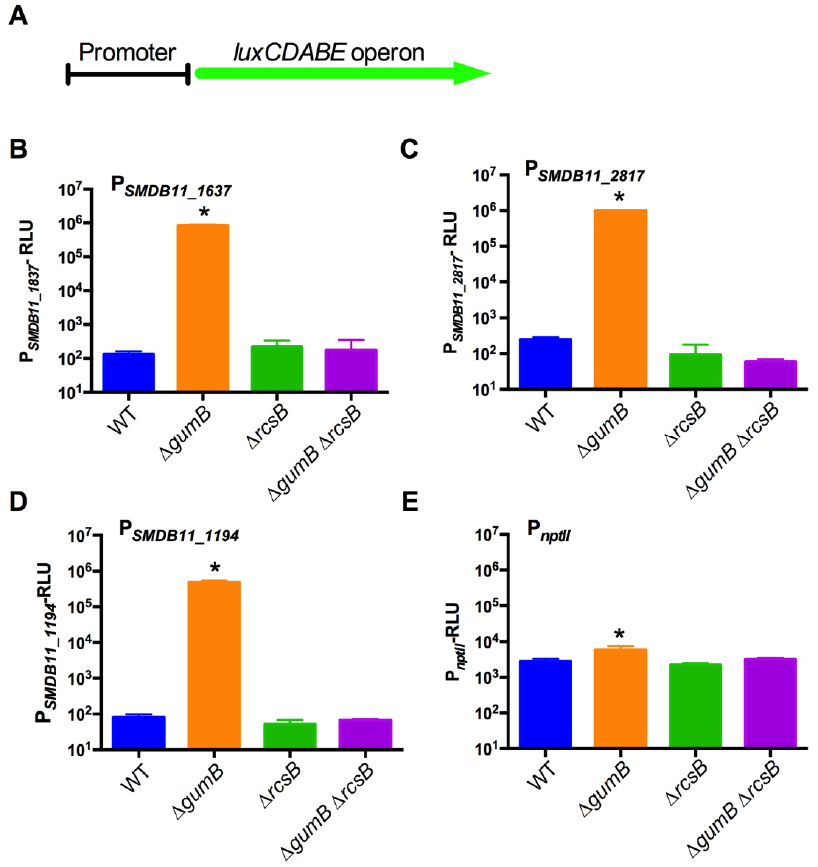
Figure 2. Validation of Rcs-responsive transcriptional reporter plasmids. ( A ). Schematic diagram